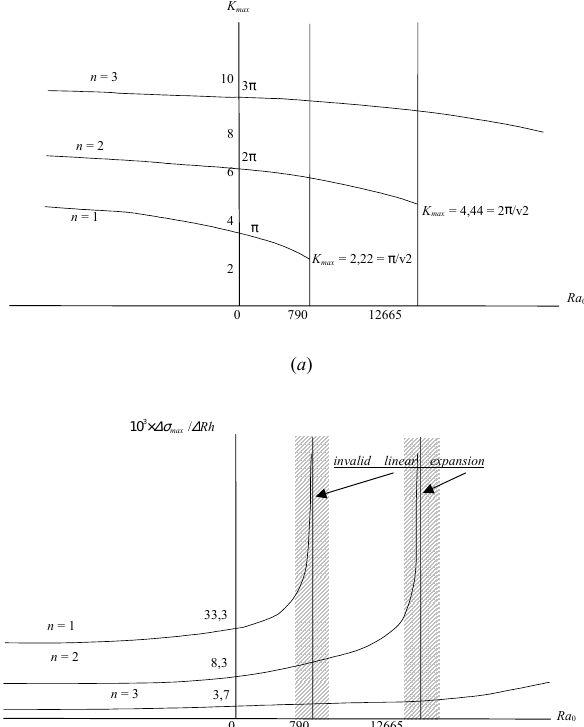
Fig. 3. Wave number K max ( a ) and growth rates ( b ) of the three first stationary unstable modes. The numerical values are the same as in Fig. 1 (the scales are not respected on the figure for R a 0 ). The x -axis is taken along the stationary threshold, the variable being the Rayleigh number R a 0 . The figure is invalid in the vicinity of the asymptotes and, in particular, R aa (shaded region), because the linearized formula (71) becomes invalid. It is also invalid when R a > R aa , because this region is already unstable. When R a 0 → −∞ , | 1σ/1R h | → 0 very slowly (as | R a | − 1 / 2 ) 0